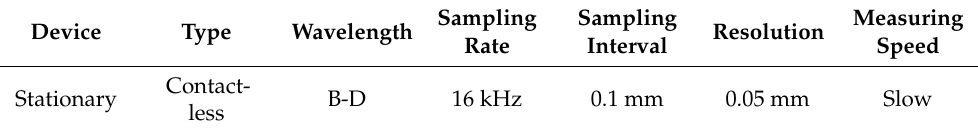
Table 2. Characteristics of Profilometer Laser.